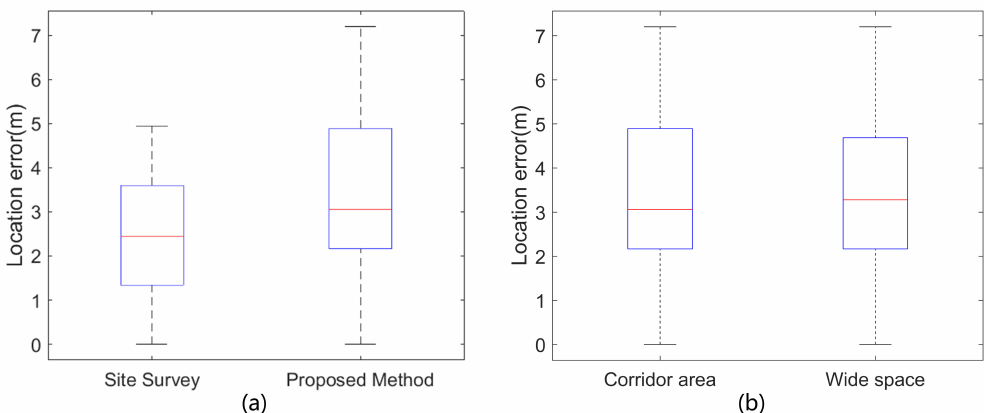
Figure 10. Localization performance of the proposed method. ( a ) The localization error of two methods; ( b ) The localization error of the proposed method in two difference indoor